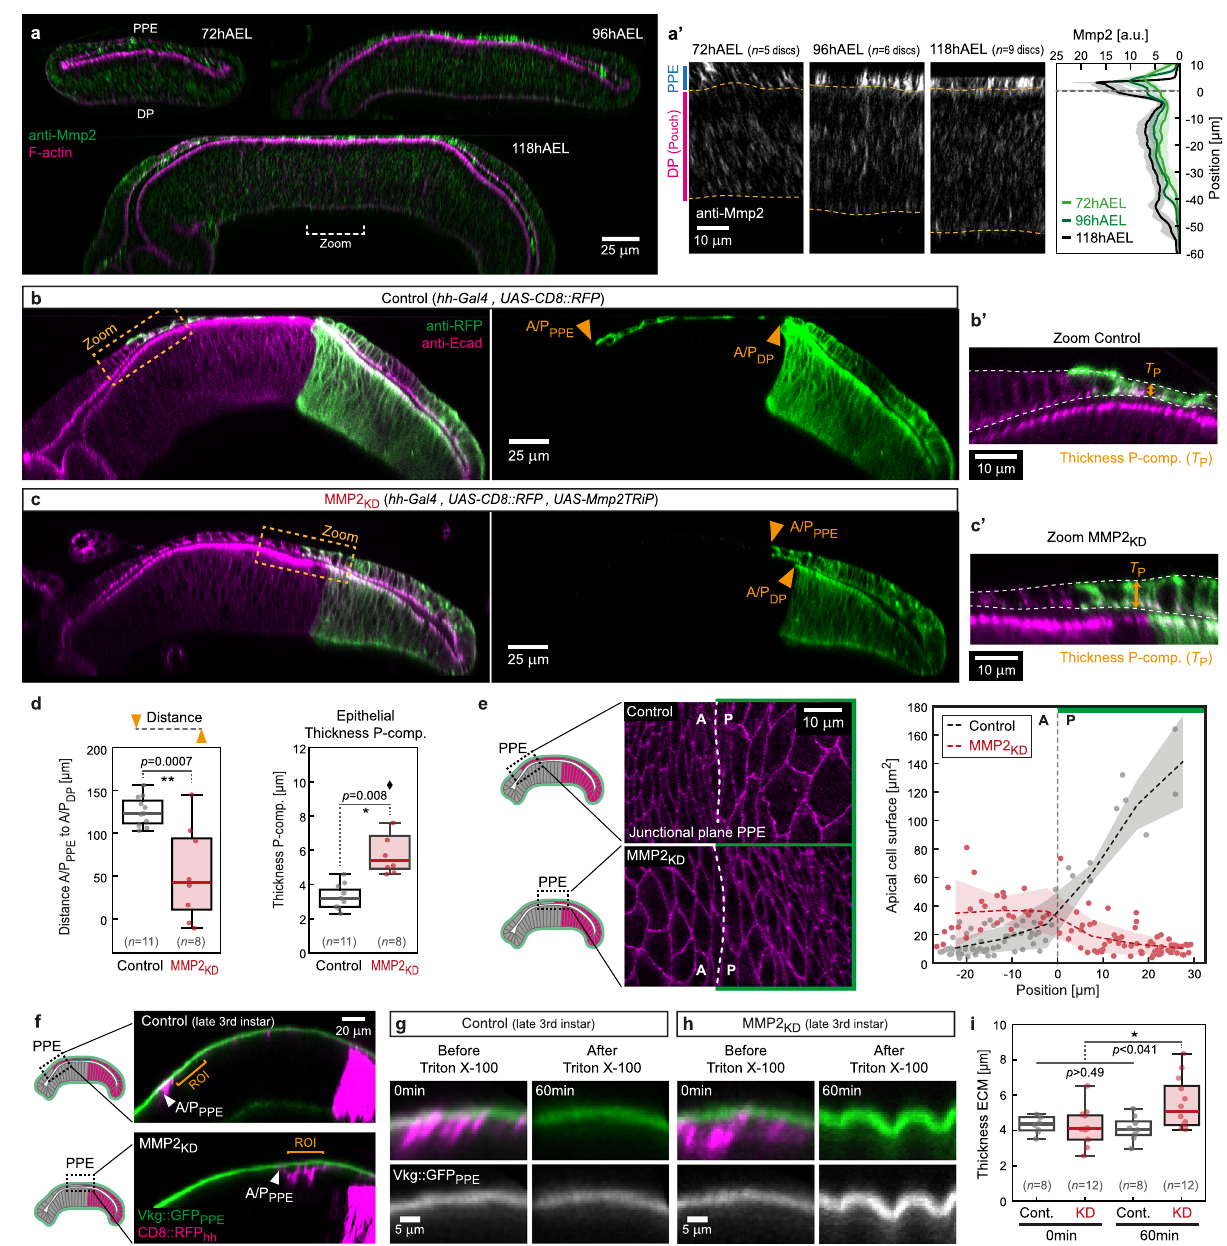
Fig. 6 | MMP2 modulates peripodial ECM growth anisotropy. a Section views of wingdiscsstainedforMMP2(green)atindicatedtimepointsandmagni fi cationsof thepouchregion( a ’ ,dashedlinesmarkDP).Right:quanti fi cationofaverageMMP2 fl uorescence intensity distribution (dashed line indicates DP apical surface, error bands indicate the standard deviation). b Section view of control wing discs expressing RFP (green) in the posterior compartment. A/P-compartment bound- aries are indicated in the PPE (A/P PPE ) and in the DP (A/P DP ) by arrowheads. b ’ Magni fi cation of the A/P boundary region, indicated in ( b ). c In MMP2 KD wing disc theP-compartmentinwhichMMP2inknocked-downismarkedbyRFP(green).The A/P boundary region is magni fi ed in ( c ’ ). d Left: quanti fi cation of the distance betweentheA/PboundaryinthePPEversustheDPlayer. n indicatesthenumberof discs.Right:quanti fi cationofepithelialThickness( T P )asindicatedin(b ’ +c ’ ). e Left: representative magni fi cations of the peripodial A/P boundary region in x/y -view (junctional plane) in control (top) and MMP2 KD (bottom). Right: quanti fi cation of